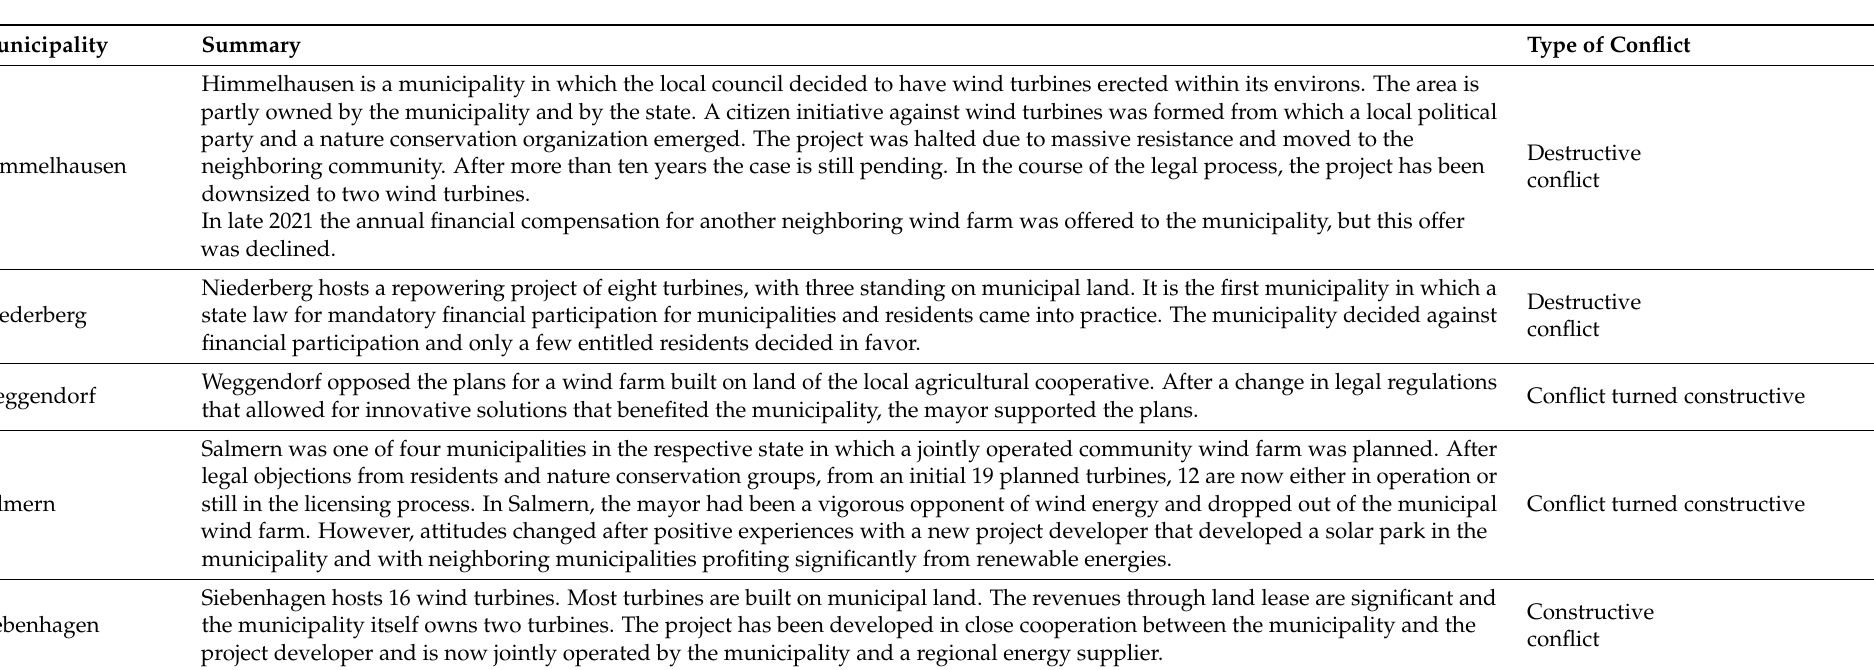
Table 2. The selected case